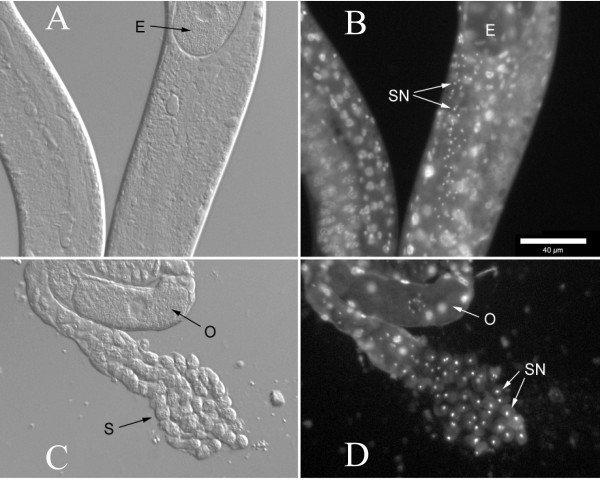
Identification of sperm and sperm nuclei from hermaphroditic Panagrolaimus strain JU765. DIC imaging was used to identify sperm (left, panels A and C) and epifluorescence imaging was used to identify characteristically compact sperm nuclei (right, panels B and D). See Methods for details. A and B show nematode midbodies; C and D show a dissected spermatheca. Ann egg is indicated by "E", sperm nuclei by "SN", oocytes by "O", and sperm by "S". The scalebar represents 40 μm.